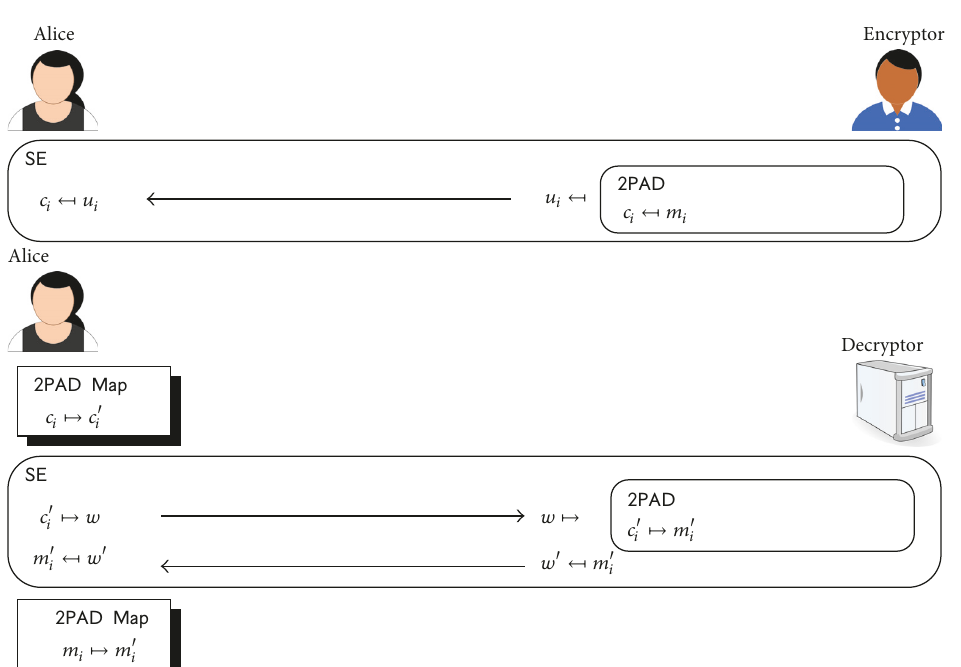
Figure 6: General overview of SymmetricBlind . Two tiers of encryption are applied. The outer tier ( SE ) satisfies ordinary perfect secrecy. The inner tier ( 2PAD ) provides perfect leak-freeness against Alice and has a transformation property enabling perfect blindness against the